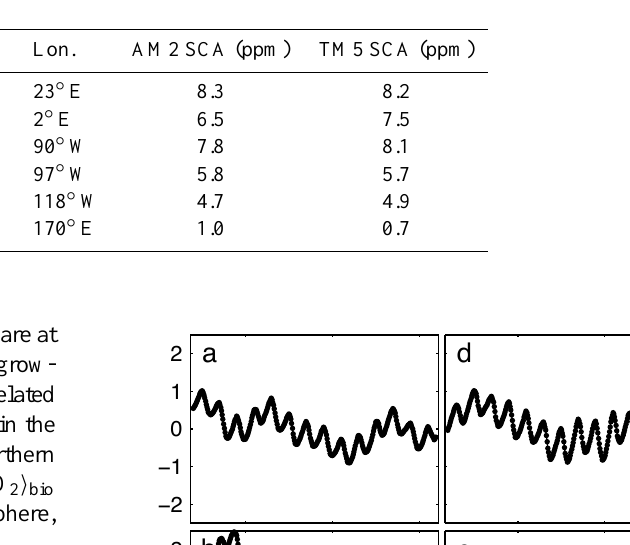
Even during the middle of the growing season, only a small fraction of the variation in middle and high latitude h CO i 2 bio is due to local fluxes. Figure 5 shows the relation- ship between flux and CO 2 in the column at the midlatitude gridbox (Park Falls) for June. In Fig. 5, the difference in CO 2 between the time with maximum concentration ( ∼ 08:00 lo- cal time) and minimum concentration ( ∼ 15:00 local time) is plotted against the integrated flux for this seven-hour pe- riod. The change in h CO 2 i bio shows a positive correlation with flux: greater uptake by the biosphere leads to drawdown in the column. The solid line in Fig. 5 represents the